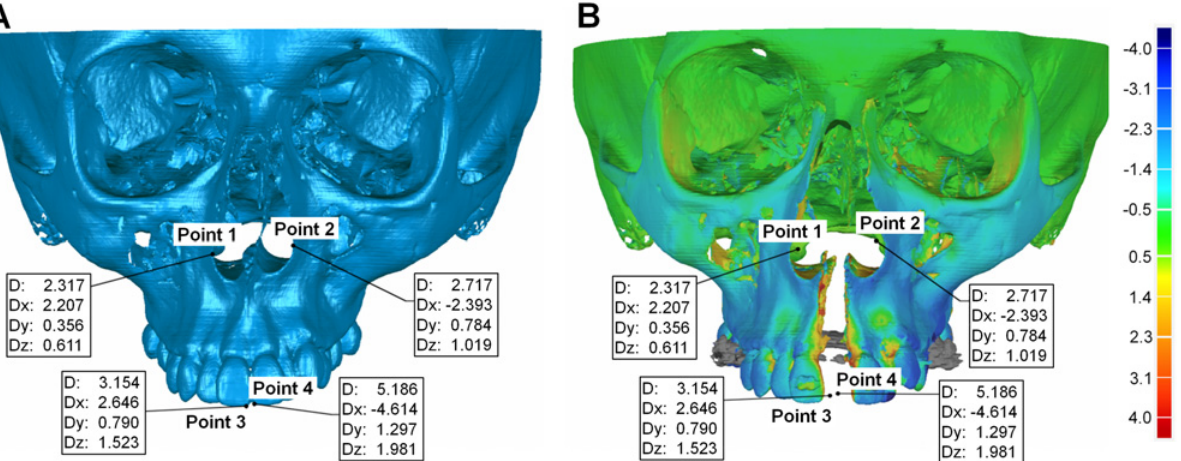
Fig 3. Visualization of a superimposition on the anterior cranial base + foramen magnum. Frontal view of the superimposition of two serial 3D datasets (T0 and T1) on the anterior cranial base + foramen magnum. Quantification of structural changes at four specific points, overall (D) and in all three planes of space (Dx, Dy, Dz), in (A) the pre- and (B) the post-treatment model, where color-coding was also used. These were the most lateral points of the piriform aperture on the left and right side (points 1 and 2) and the most labial point of the mesio-incisal corner of each central incisor (points 3 and 4). All values are in mm. The grey area in the color-coded model is due to the metal artefact produced by the Hyrax appliance. The software was unable to compare corresponding polygons at that site, because the appliance was present only in one model (T1).